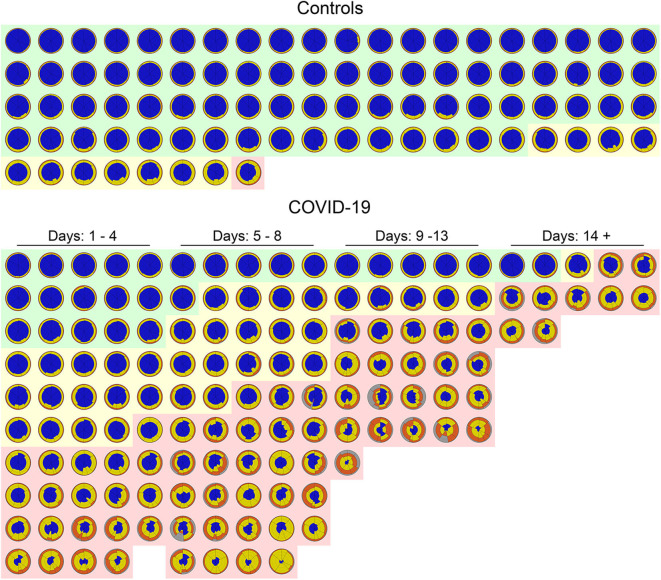
Glyphs of all CT scans of 88 controls (upper panel) and 141 COVID-19 CT scans (lower panel). In the control group, glyphs were sorted by the extent of parenchymal opacities related to ground glass opacities (GGO), CP/LO, and consolidation. Note that just 11 (12%) subjects presented some parenchymal opacities, whereas in just one subject (1%) such opacities presented a Z score higher than 3. Also note that there is a clear predominance of GGO in controls. In COVID-19, glyphs were sorted by days of symptom onset and by the extent of pulmonary involvement with the three classified groups: severe (light red cluster), moderate (light yellow cluster), and mild (light green cluster). Patients' glyphs clearly demonstrate the spectrum of parenchymal abnormalities showing a variety of GGO, CP/LO, and consolidation. Note the predominance of yellow and orange (GGO and CP/LO, respectively) in patients classified as presenting severe pulmonary involvement and with longer time since symptom onset. There are few “normal” subjects (22%) in the COVID-19 database, and therefore only a minority of glyphs are predominantly blue all over the lung.